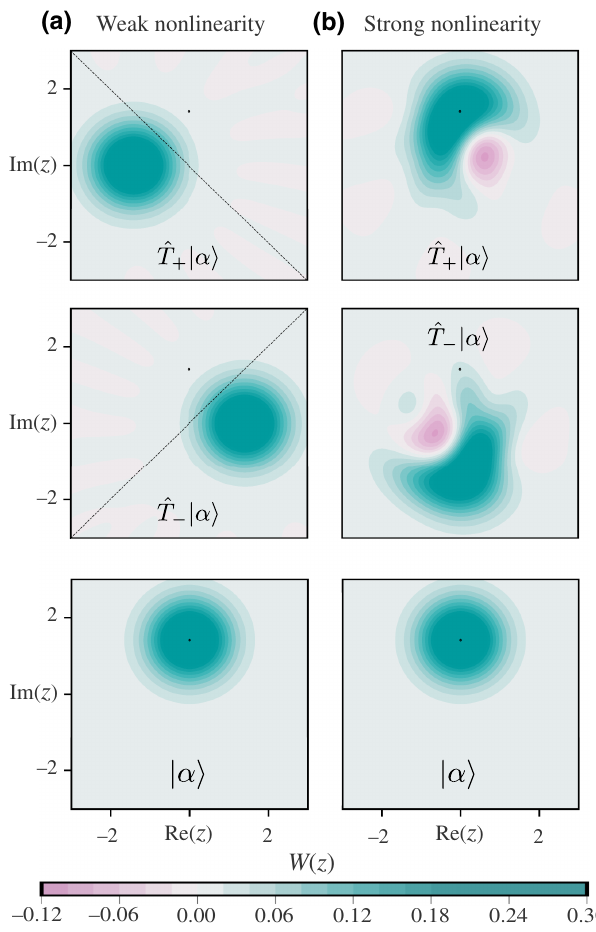
FIG. 5. Hidden time-reversal symmetry operations in a para- metrically driven Kerr cavity. For vanishing single-photon drive (cid:15) 1 , the driven-dissipative cavity model in Eqs. (56) and (57) has two distinct hidden time-reversal symmetries, corresponding to antiunitary operators ˆ T ± . Here, we plot the Wigner functions of the states ˆ T σ | α (cid:6) , where | α (cid:6) is a coherent state (amplitude α = √ 2 i , black dots). (a) For weak nonlinearity, K = 5 × 10 − 4 κ 1 , and two-photon drive (cid:15) 2 = 6.25 × 10 − 5 κ 1 , ˆ T ± are simple phase- space reflections about the axes θ = ± arg ((cid:15) 2 / i κ) (indicated by dashed black lines). (b) For strong nonlinearity, K = κ 1 , (cid:15) 2 = κ/ 8, hidden-TRS operations become highly non-Gaussian, as indicated by the presence of significant Wigner negativity in the final states.